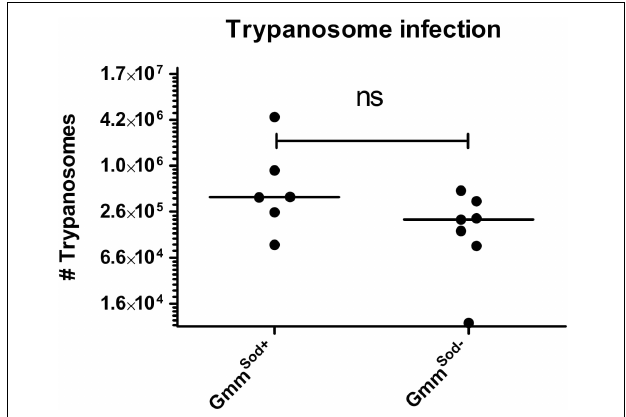
FIGURE 10 | Trypanosome infection density in the tsetse fly midgut of symbiotic ( Gmm Sod + ) and S. glossinidius -free ( Gmm Sod − ) flies 28 days after they received a Trypanosoma brucei brucei -parasitized blood meal one day post-eclosion. The trypanosome density was determined using a standard curve-based trypanosome-specific qPCR assay. Values show the density in each midgut and are represented as the median per group. N = 6 independent replicates for the Gmm Sod + group and N = 7 independent replicates for the Gmm Sod − group. The number of trypanosomes is represented in log-scale on the y-axis. Ns, not